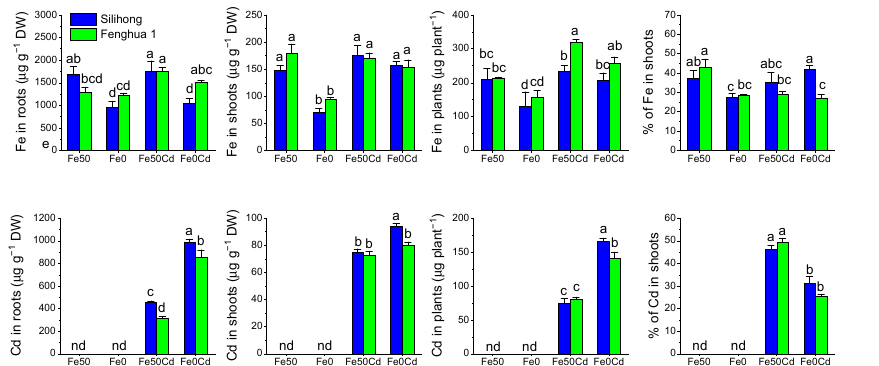
Figure 8. Fe/Cd accumulation and translocation in two peanut cultivars exposed to 0 or 2 μ M Cd under Fe-sufficient (Fe50) and Fe-deficient (Fe0) conditions for 14 days. Data (means ± SE, n = 3) sharing the same letter(s) above the error bars are not significantly different at the 0.05 level based on the Duncan multiple range test. nd, not determinable.